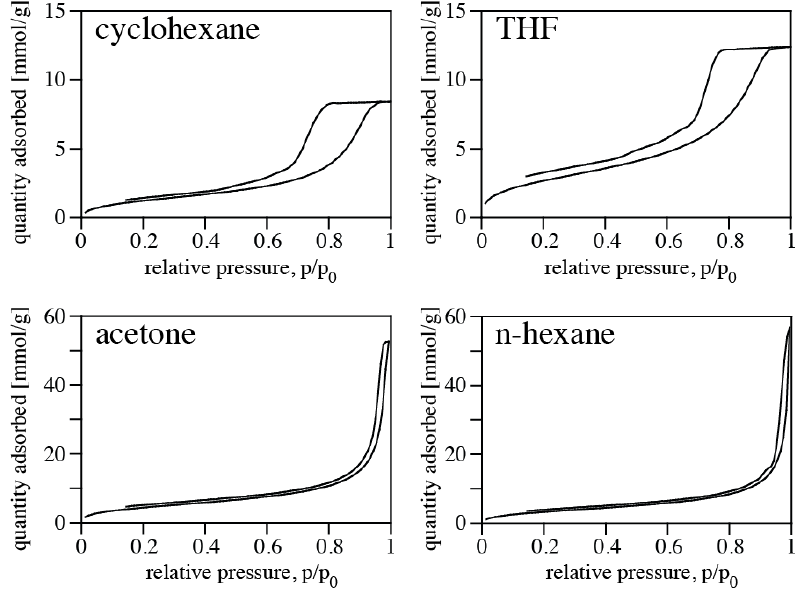
Figure 3. Nitrogen sorption isotherms (at 77 K) of PMHS/DVB polymer aerogels synthesized in cyclohexane ( top left ), tetrahydrofuran ( top right ), acetone ( bottom left ), and n-hexane ( bottom right ).